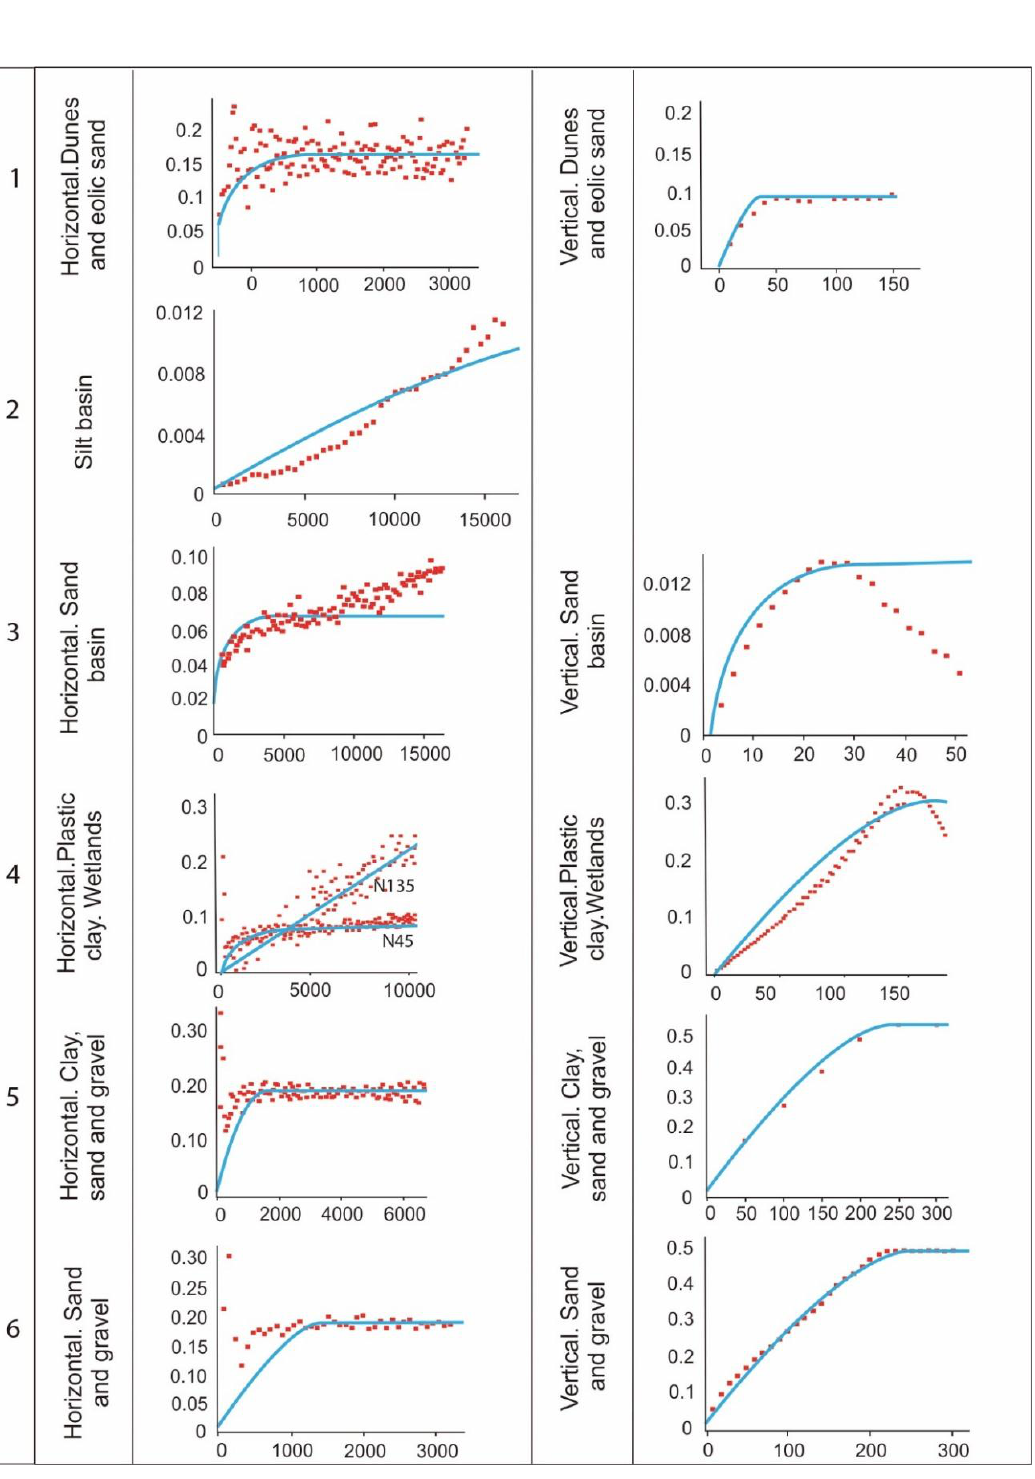
Figure 5. Modeled variograms (horizontal and vertical) of hydrofacies.